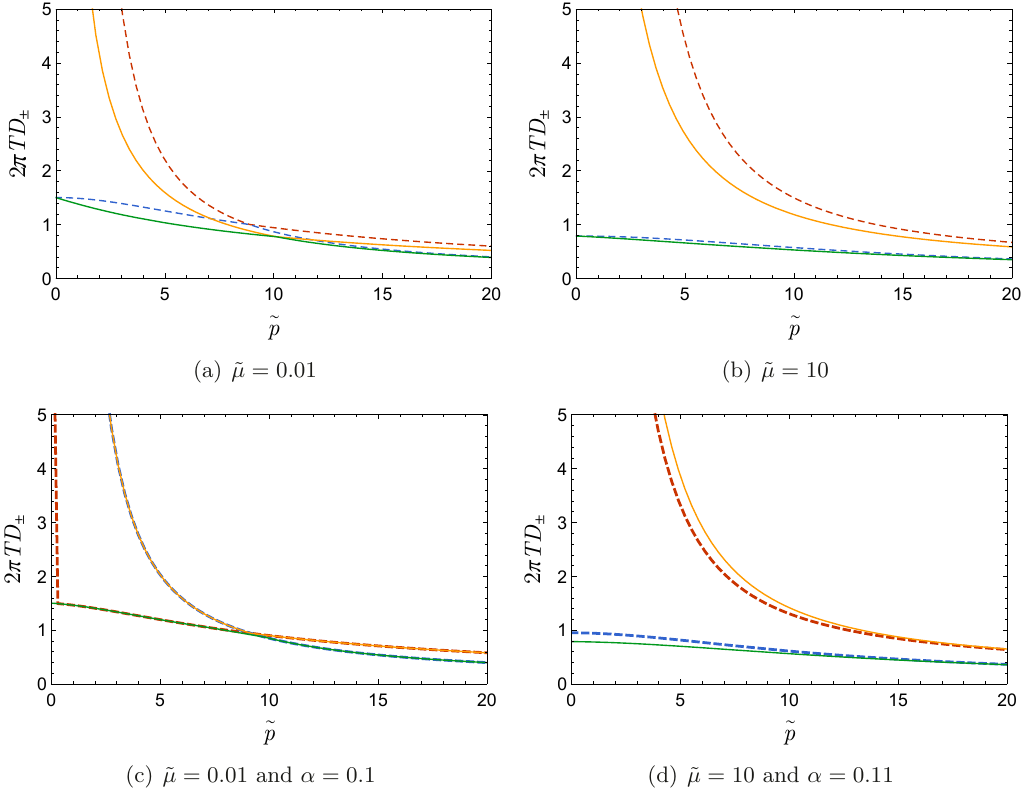
Figure 2 . We considered ˆ η = 1 for the plots. In subfigures (a) and (b), the dashed lines are for α = 0, whereas the solid ones are for α = 0 . 5. Red and yellow lines show 2 πTD + vs. ˜ p , whereas blue and green ones depict 2 πTD − vs. ˜ p . In subfigures (c) and (d), we display the mixing feature. The red (blue) thick dashed line shows 2 πTD c vs. ˜ p , whereas the yellow (green) solid one depicts ( e ) 2 πTD vs. ˜ p +( − )